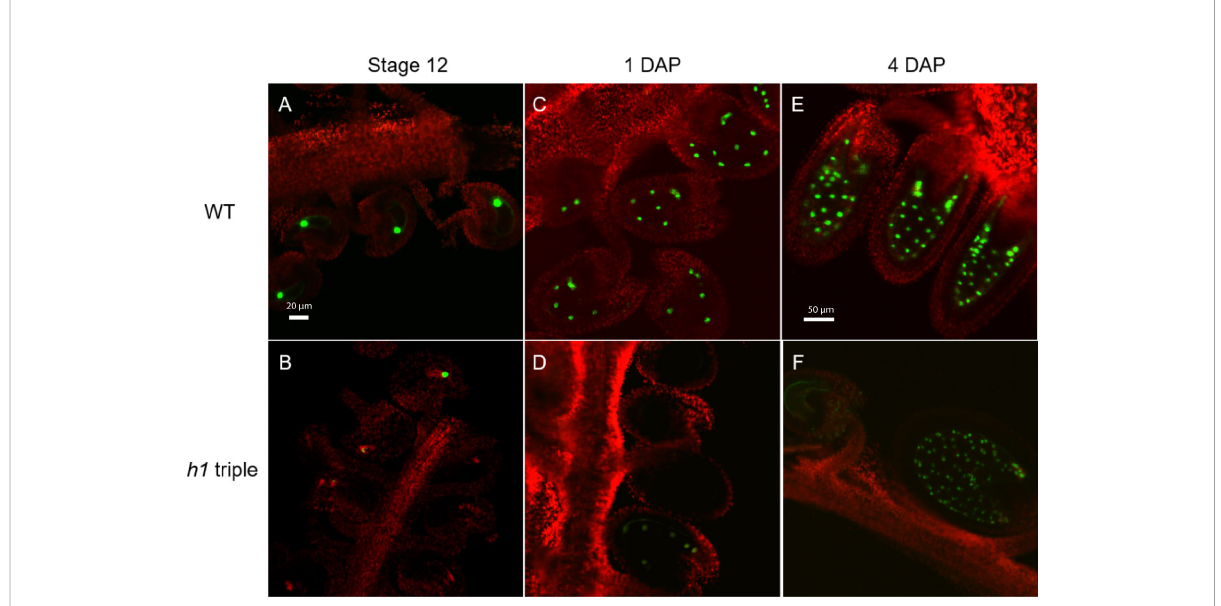
FIGURE 2 Expression of the H1.2 promoter::GFP transgene is reduced in the central cell of h 1 hybrid endosperm. Fluorescence images of pMEA::GFP expression signals in wild type (A, C, E) and in h1 triple mutant endosperm (B, D, F) . The GFP and chlorophyll fl uorescence signals were pseudo- colored as green and red, respectively. Fluorescence micrographs of ovules at fl ower stage 12 (A, B) , 24-hr after pollination (C, D) , and 96-hr after pollination (E, F)